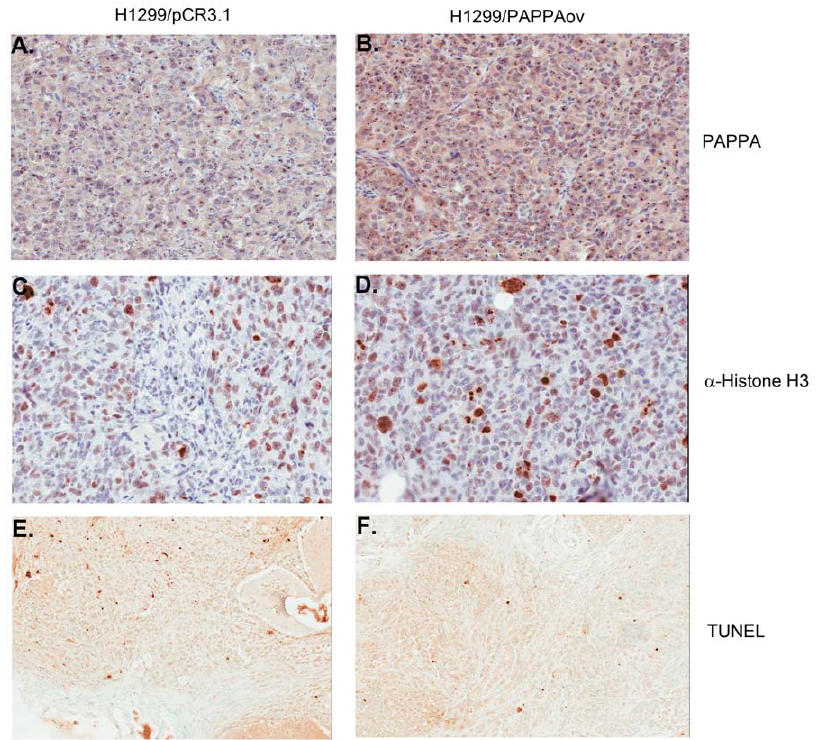
Figure 6. Immunostaining of xenograft tumors from H1299 cells for PAPPA expression (A and B), cell proliferation (C and D with histone H3 antibody) and apoptosis (E and F with TUNEL). A, C and E: xenograft tumors from H1299/pCR3.1 cells; B, D and F: xenograft tumors from H1299/PAPPAov.